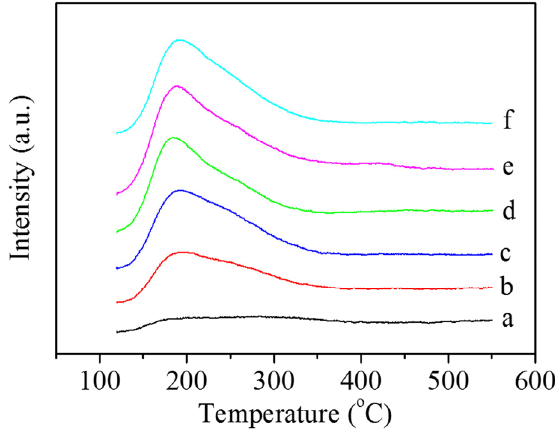
Figure 7. NH 3 -TPD (temperature-programmed desorption) profiles of V/SBA catalysts with different vanadium content. ( a ) 1% V/SBA; ( b ) 3% V/SBA; ( c ) 5% V/SBA; ( d ) 7% V/SBA; ( e ) 7% V/MCM; ( f ) 11%